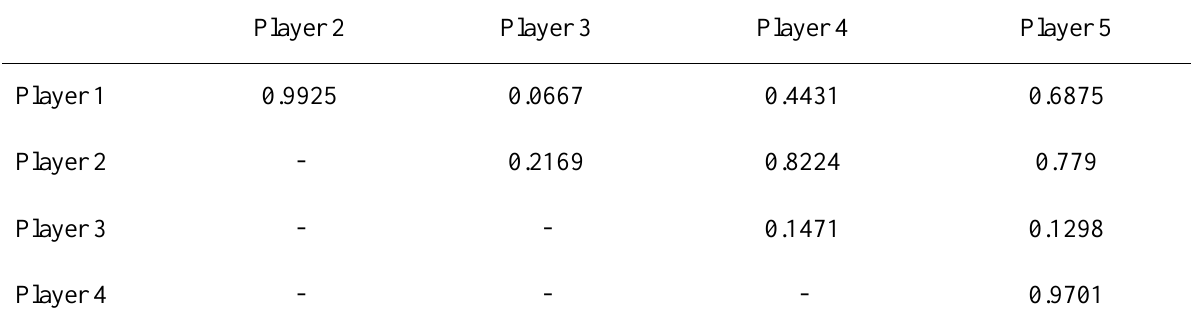
extraction by players at different positions during the baseline phase of the experiment (32 observations for each position).